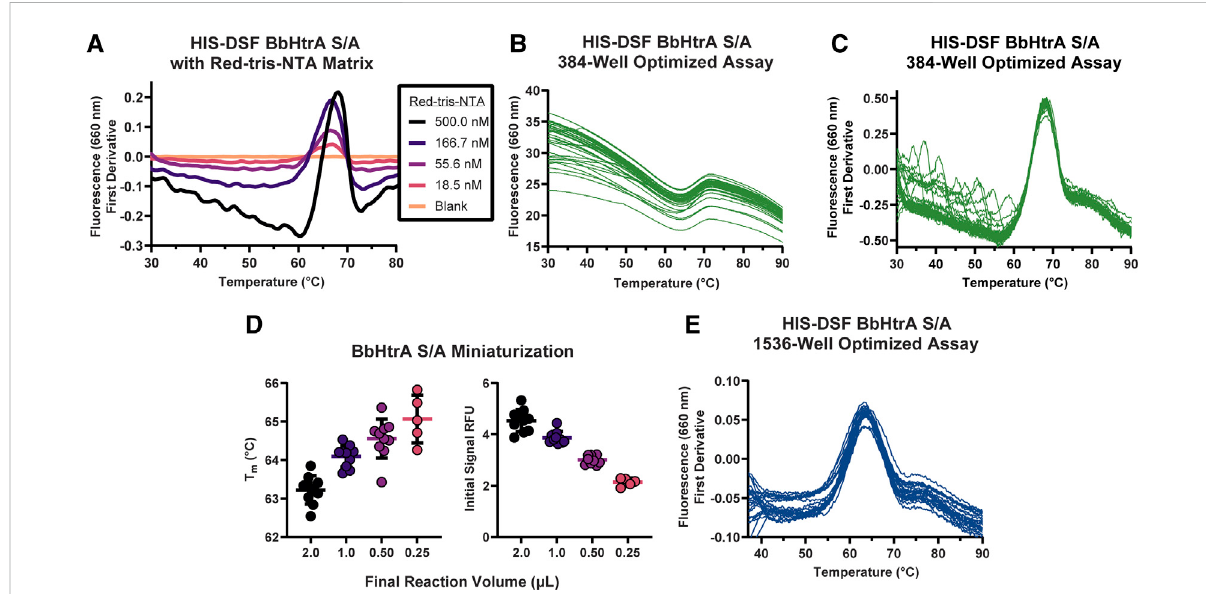
FIGURE 2 Establishing conditions and miniaturization of the HIS-DSF assay. (A) A titration matrix of BbHtrA S/A and Red-tris-NTA concentrations was pro fi led for its performance in a DSF temperature ramp. Pictured is a representative experiment of the 3.5 µM protein concentration group, with individual curves representing different concentrations of Red-tris-NTA or buffer. (B) Raw thermogram traces for n = 36 replicates of the matrix- derived best concentrations of protein and dye in 384-well format. (C) First derivative of the n = 36 replicate wells of the optimized HIS-DSF reaction. (D) Scatter plot of T m and initial signal RFU values from miniaturization of the HIS-DSF BbHtrA S/A reaction into 1536-well format. Lines represent the mean of ten replicates with error bars representing the standard deviation. (E) The fi rst derivatives of raw thermogram traces for n